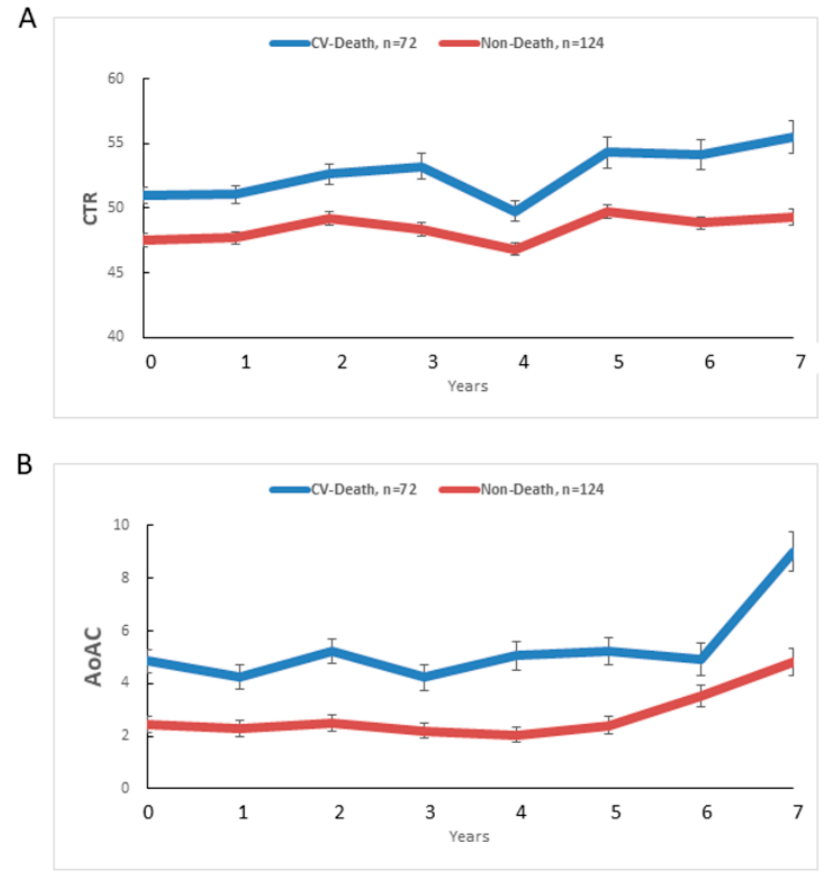
Figure 3. Mean CTR ( A ) and AoAC ( B ) at each follow-up year for cardiovascular death (blue, n = 72) and non-death (red, n = 124) patients. Table 6. Time course of mean change in CTR or AoAC from baseline (0 year) to 7 years in cardiovascular death and non-death